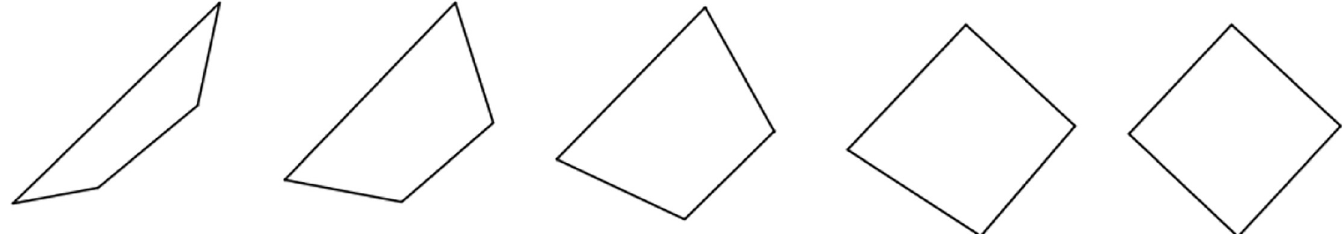
Fig 9. Geometric transformation process of a quadrilateral